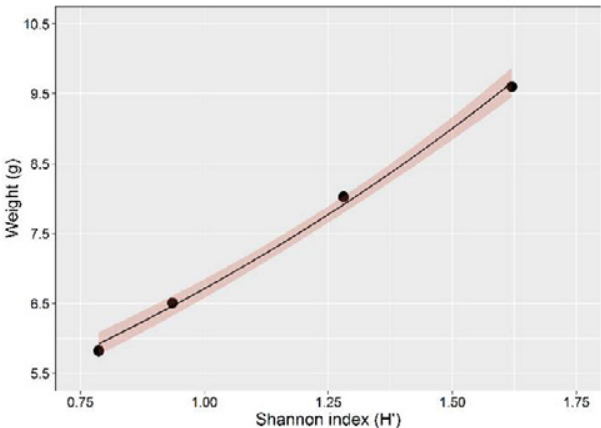
Fig 6 . Relationship between canola grain yield (seed weight) and bee diversity (Shannon index, H’). Note: Points denote observed values; line denotes the predicted model (Gaussian family GLM); pink-shaded area denotes the 95% confidence interval. Model fit: pseudo-R 2 = 0.99.